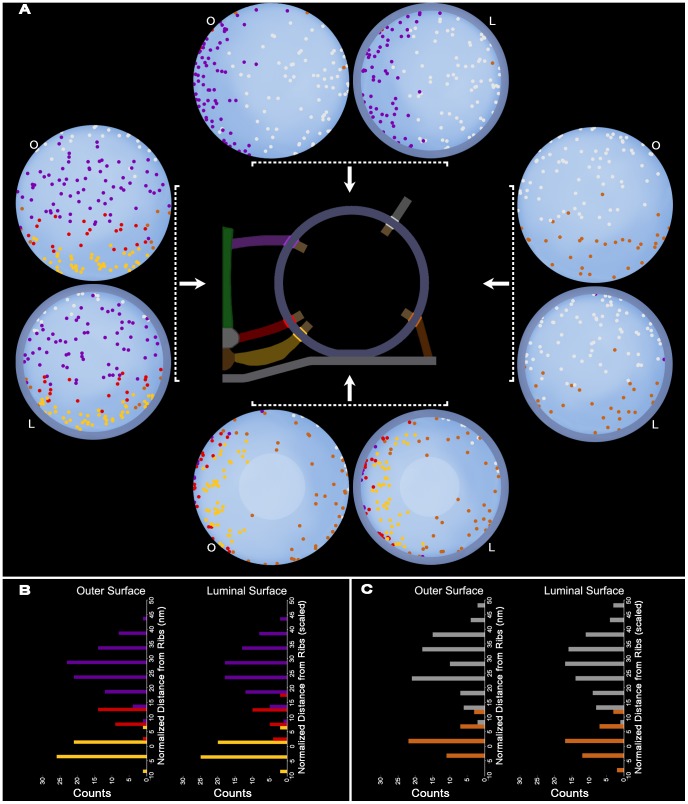
Composite maps of nub, AZM and non-AZM macromolecule connection sites.(A) The centroids of the connection sites of different classes of AZM macromolecules, non-AZM macromolecules and nubs on the membrane of 11 docked vesicles from 4 active zones are plotted on the outer (O) and luminal (L) surfaces of an idealized vesicle. The hemispheres are viewed from (→) or toward (←) the midline of the main body of the AZM or from (↑) or toward (↓) the presynaptic membrane as indicated in the schematic of the active zone. The connection sites of ribs (gold), spars (red), booms (purple), pins (copper) and non-AZM macromolecules (pewter) were plotted on the idealized vesicle, while maintaining their relative positions per vesicle, using a cross correlation method that maximizes the degree of overlap of the rib connections to the outer surface (see Methods). The connection sites of nubs were plotted according to the same method using the nub connection sites paired with rib connection sites as the reference. Nub connection sites are color-coded according to the class of AZM/non-AZM macromolecules with which they were paired. There is an asymmetric distribution of AZM/non-AZM connection sites between the hemisphere facing the median plane of the AZM and the hemisphere facing away from the AZM, which is mirrored by an asymmetric distribution of nubs. Similarly, the asymmetric distribution of AZM/non-AZM connection sites between the hemisphere facing the presynaptic membrane and away from the presynaptic membrane, also is mirrored by an asymmetric distribution of nubs. The distribution of nub and AZM/non-AZM connection sites on the hemisphere facing the presynaptic membrane is greatly affected by the absence of such connections in the fusion domain (within the pale circular area). (B,C) The frequency of the connection sites of the different classes of main body AZM macromolecules on the outer surface and their paired nubs on the luminal surface (B), and non-AZM macromolecules and pins on the outer surface and their paired nubs on the luminal surface (C), as a function of distance from the average rib position per vesicle (see methods). The plots of the nub connections in (B) and (C) are normalized (scaled) for differences between the luminal and outer diameters of the vesicle membrane. The asymmetric distribution of the connection sites of the different classes of AZM and non-AZM macromolecules on the outer surface of the vesicle membrane reflects the asymmetric distribution of connection sites of their paired nubs on the luminal surface of the membrane.